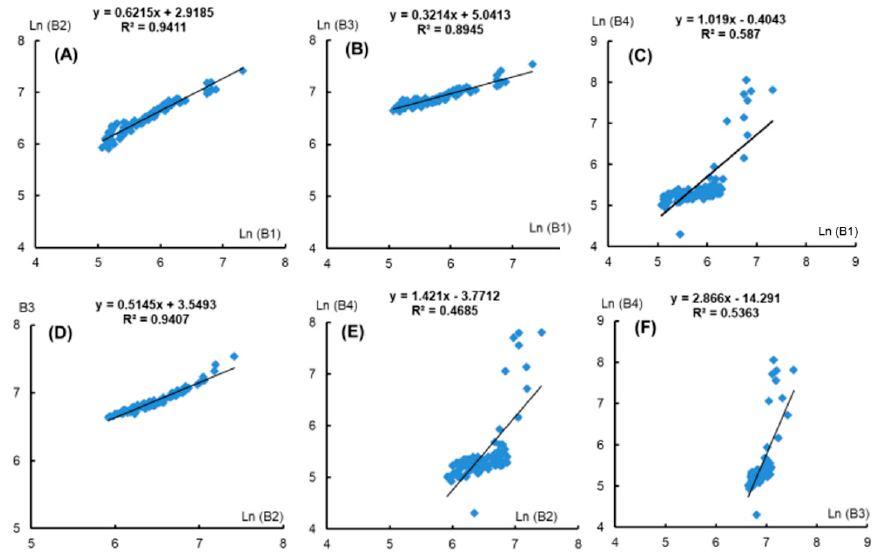
Figure 4. Several linear logarithm relationships of reflectance spectra between band i and band j from VNREDSat-1 imagery: ( a ) band 1 and band 2; ( b ) band 1 and band 3; ( c ) band 1 and band 4; ( d ) band 2 and band 4; band 3 and band 4